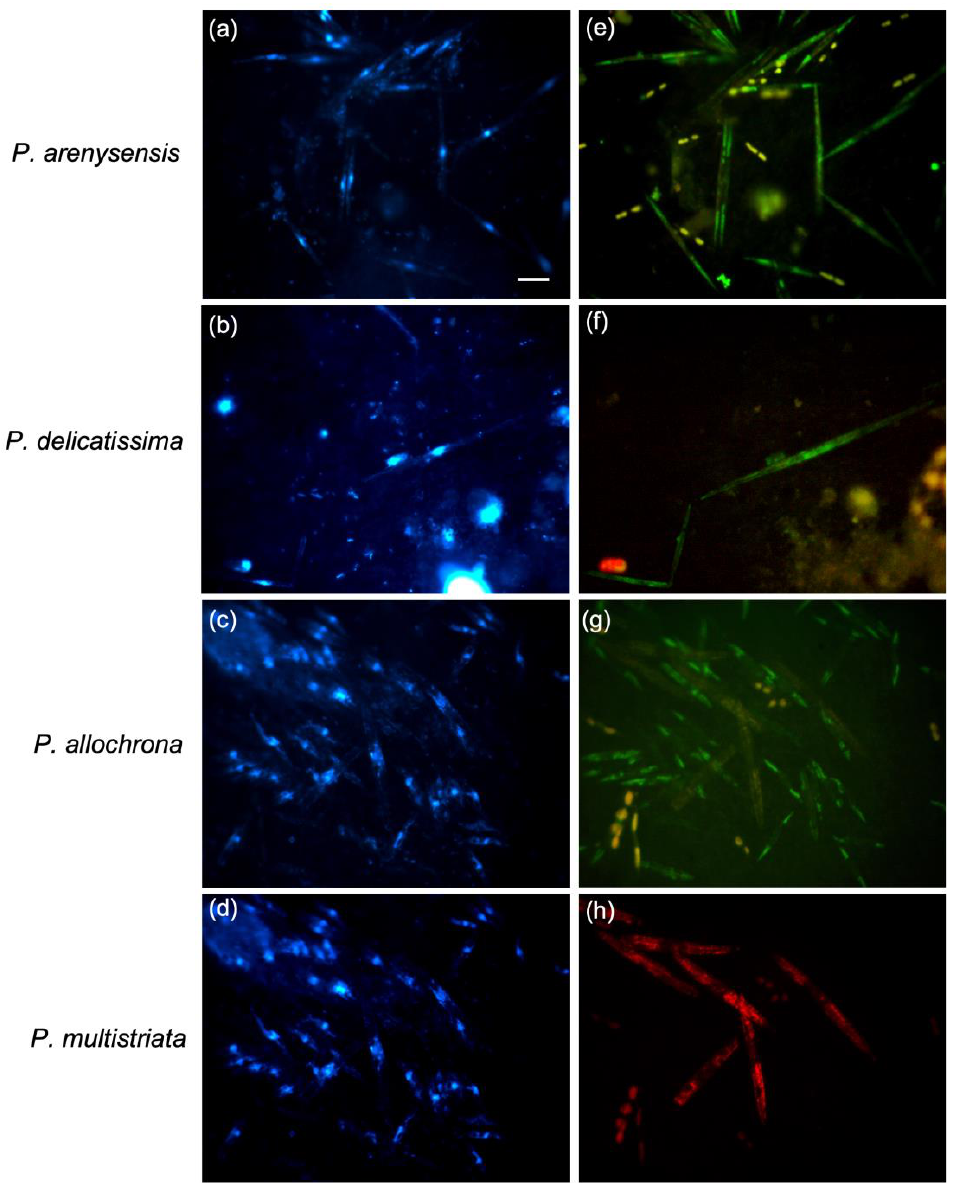
Figure 6. WC-FISH assays on natural samples targeted to species-specific cryptic Pseudo-nitzschia probes. Each row of micrographs displays cells of natural samples under fluorescence microscopy in DAPI ( a – d ) and FITC ( e – h ) filters. The last two rows of micrographs display the same sample processed as multiplex WC-FISH by using the two different probes labelled with FITC and Cy3 respectively. Scale = 10 μm.